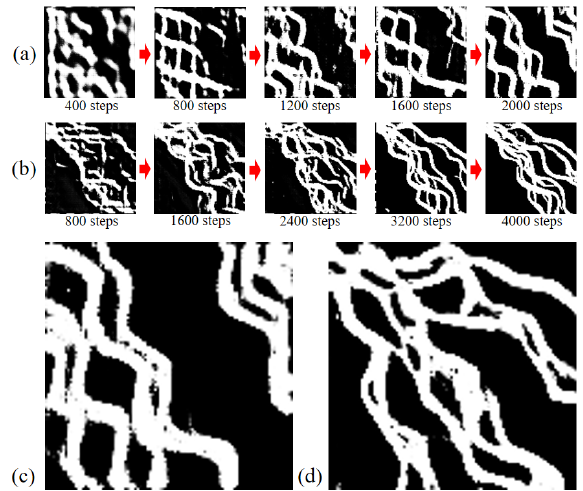
Figure 10. The results of unconditional modeling. ( a ) Unconditional modeling intermediate results of stationary problem; ( b ) unconditional modeling intermediate results of non-stationary problem; ( c ) unconditional modeling result of stationary problem; ( d ) unconditional modeling result of non- stationary problem.